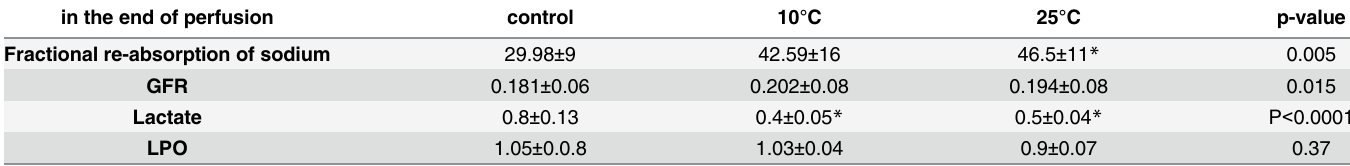
Table 3. Fractional re-absorption of sodium and lactate and LPO level in the perfusate and GFR after 90 minutes of perfusion in the control group and in the gradual rewarming groups. * P < 0.05 vs control group. Values are mean ± standard deviation. in the end of